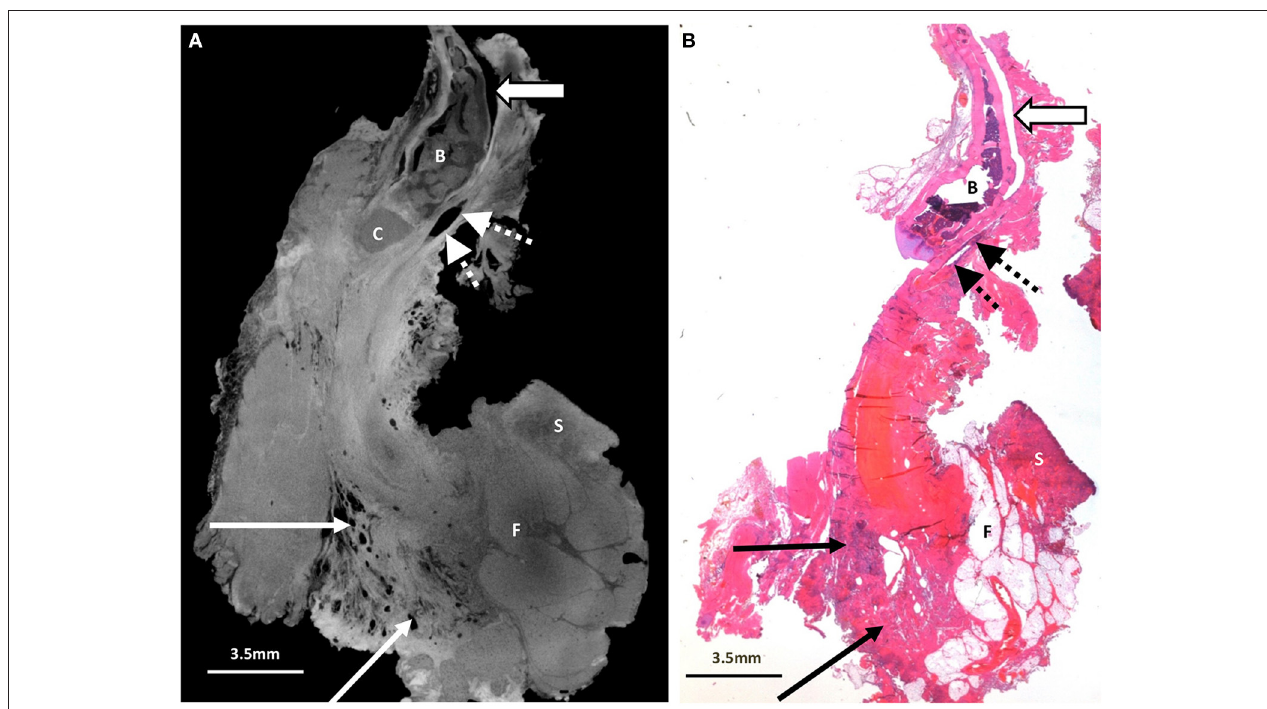
FIGURE 4 | Excised thyroglossal duct cyst specimen from a 16-month old female patient (case 4). (A) Paired iodinated micro-CT imaging at 14.2 micron resolution and (B) histopathological section with H&E staining demonstrate the thyroglossal duct (dashed arrows) anterior to the hyoid bone (B) and hyoid cartilage (C). An artefactual cleft is demonstrated with the open arrow. There is no cystic structure on this image. Some skin (S) and fatty tissue (F) from the neck was removed at surgery, and areas of chronic inflammation with tethering of the adjacent musculature and surrounding tissues (solid arrows) are shown.